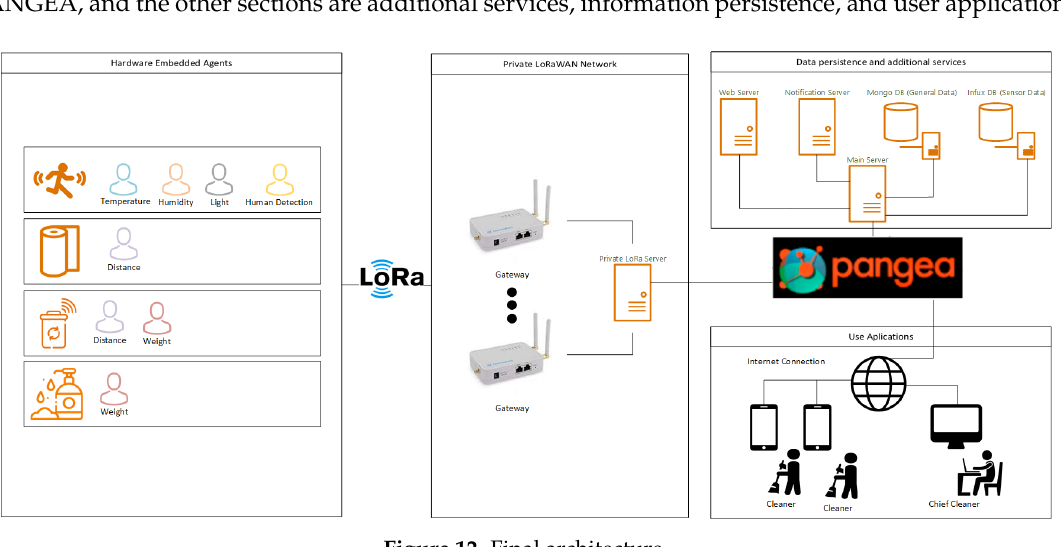
Figure 12. Final architecture.